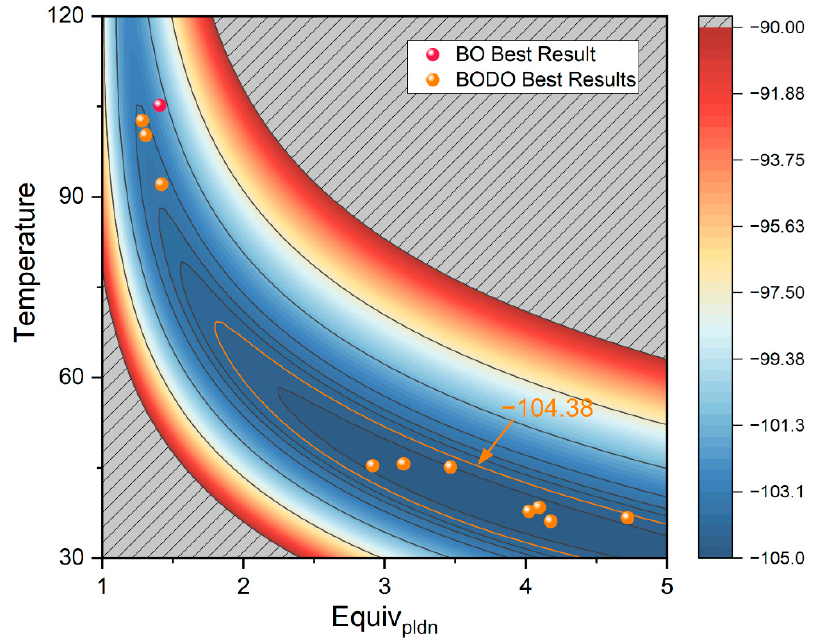
Figure 9. The best result distribution of BO and 10 random BODO runs on temperature and equiv pldn . For BO and all BODO runs, tau and conc dfnb are all optimized to their boundaries, with their optimized values as 0.5 and 0.5, respectively.